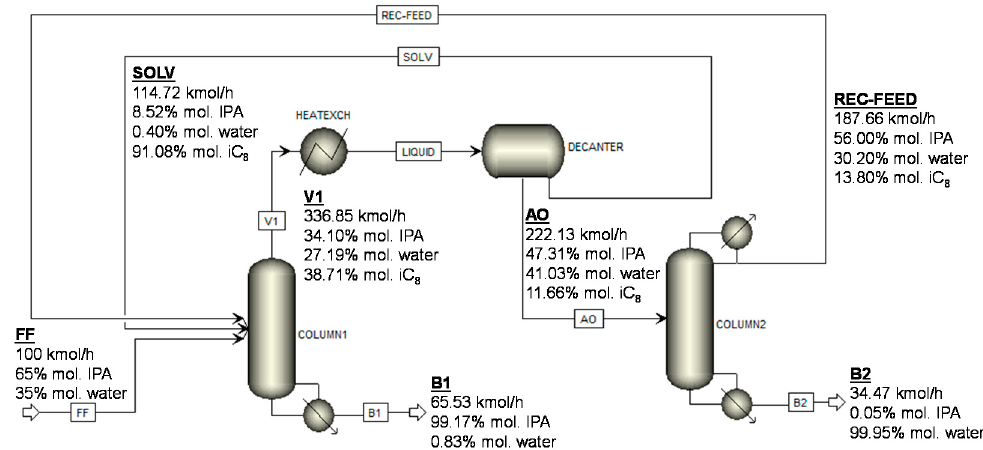
Figure 10. Flowsheet of the HAD process simulated in Aspen Plus ® V11 [61] for the separation of the mixture 2-propanol (IPA) + water using isooctane (iC 8 ) as an entrainer (with the two loops related to the recycle streams